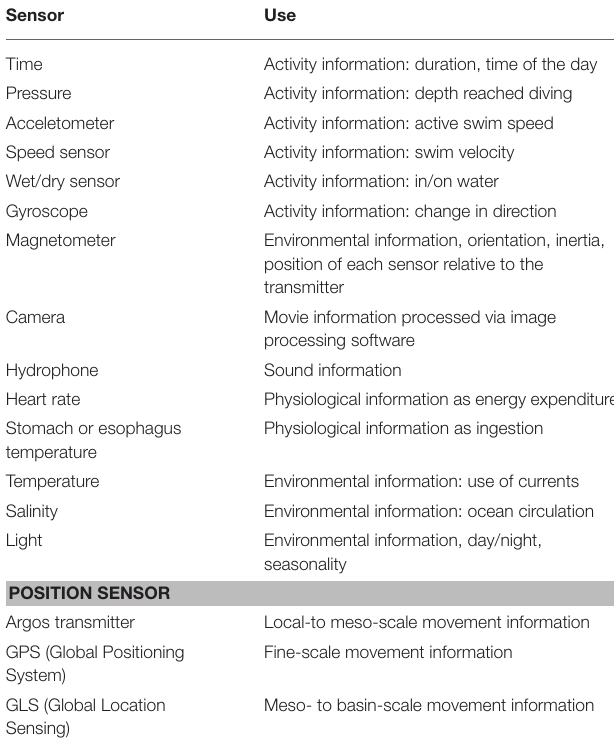
TABLE 1 | Commercially available sensor types for data loggers and their use for marine mammal and seabird